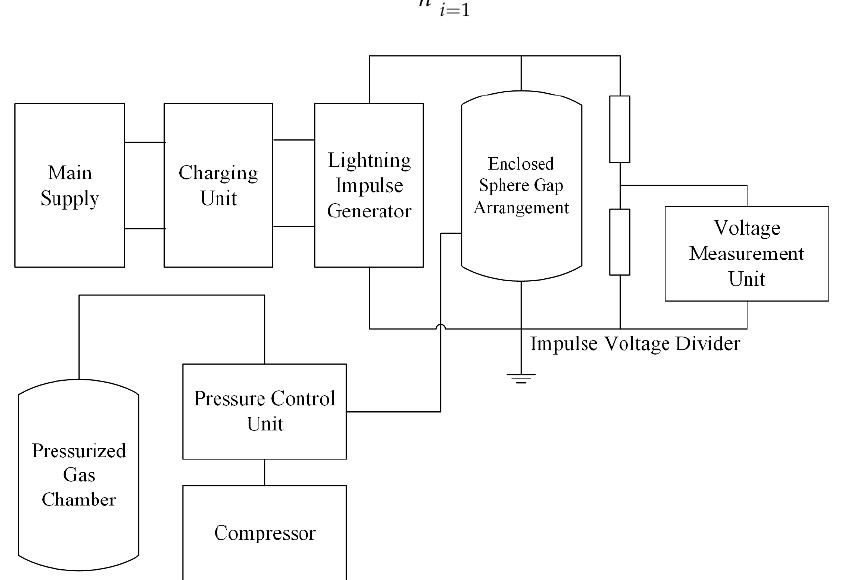
Figure 11. Experimental Setup for lightning impulse discharge test.